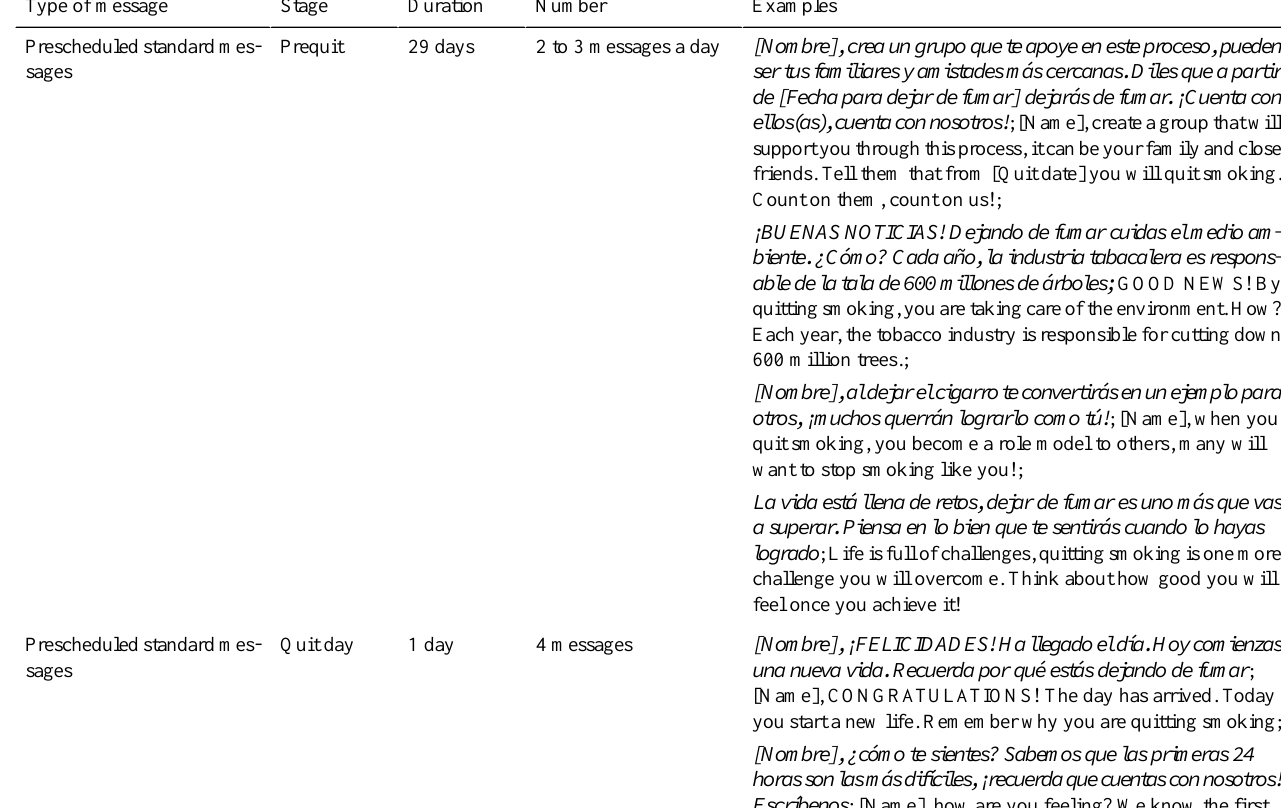
Table 1. Types of messages, stages, duration, number, and examples of text messages. ExamplesNumberDurationStageType of